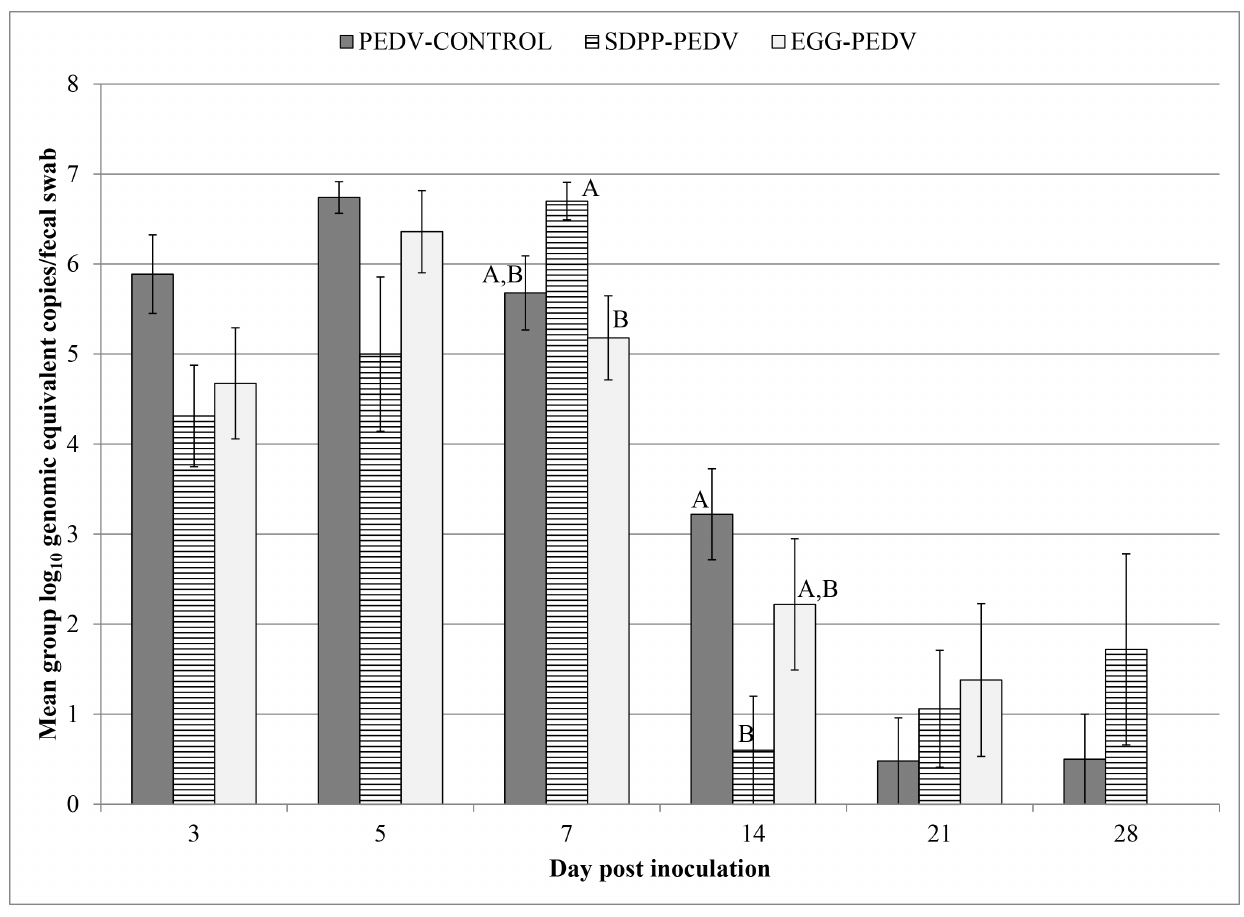
Figure 1. Group mean antibody response in serum over time. ( A ) Group mean S1 ELISA OD values 6 SEM. An OD value greater than 0.3 was considered positive, samples with OD values between 0.2 and 0.3 were considered suspect, and samples with OD values less than 0.2 were considered negative. ( B ) Group mean IFA titers ( 6 SEM). Samples were tested in 2-fold dilutions with the IFA ranging from 1:40 to 1:320. Positive signals at a sample dilution of 1:40 or higher were considered positive. The data were analyzed by one-way ANOVA method followed by Tukey’s pairwise test using the JMP software version 10.0.2 (SAS Institute, Cary, North Carolina, USA). Different superscripts ( A,B ) indicate significant different group means on selected days (p , 0.05).